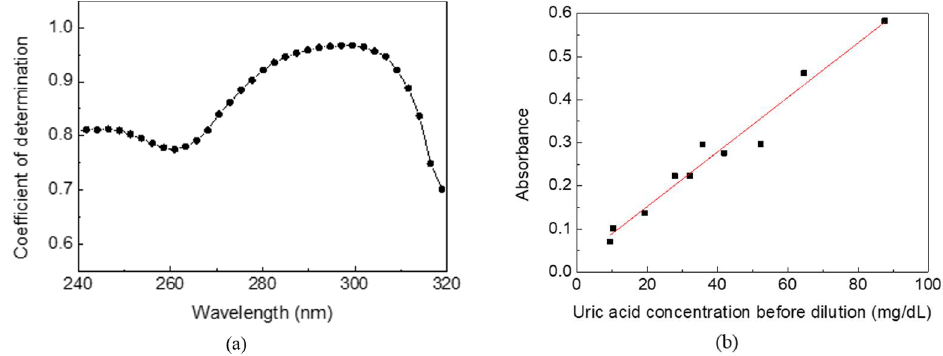
Figure 4. ( a ) The coefficient of determination distribution between the absorbance and the uric acid concentration of urine samples at wavelength 240-320 nm. ( b ) The relationship between the absorb- ance and the uric acid concentration of urine samples at 300 nm. The coefficient of determination reached its highest level at 0.9633.